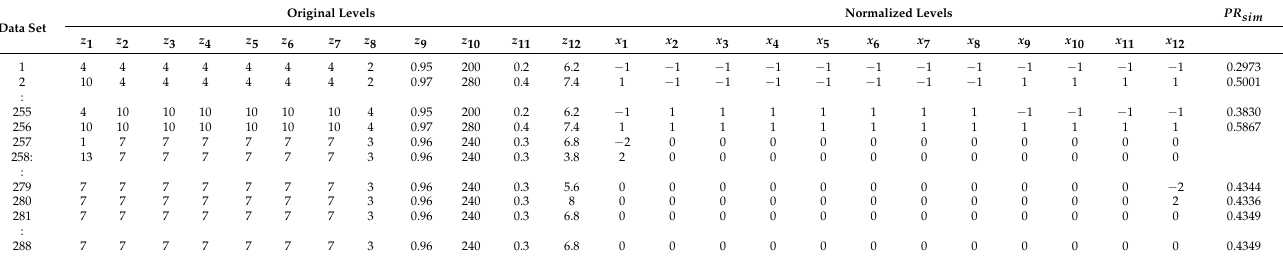
Table 5. Experiment design for building the meta-model (reconfiguration strategy